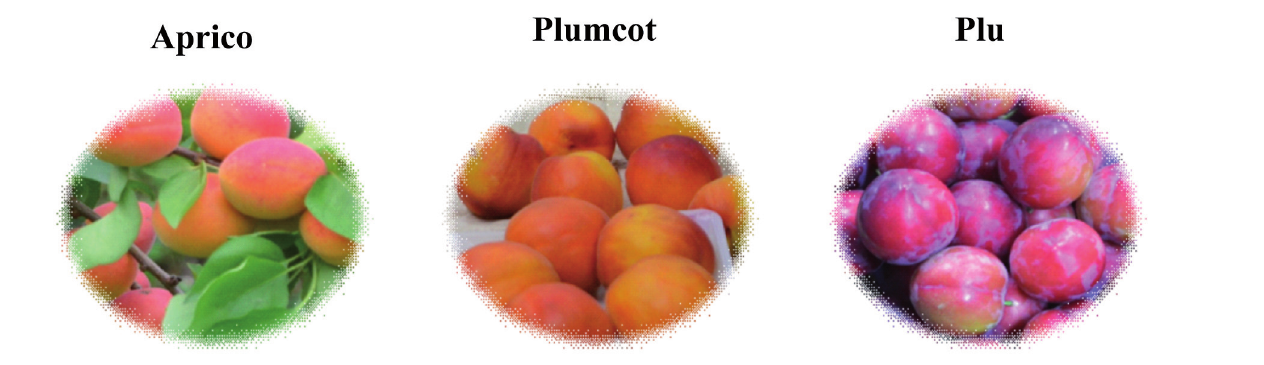
Fig. 1: Fresh fruits of apricot, plumcot, and plum harvested at the stages of